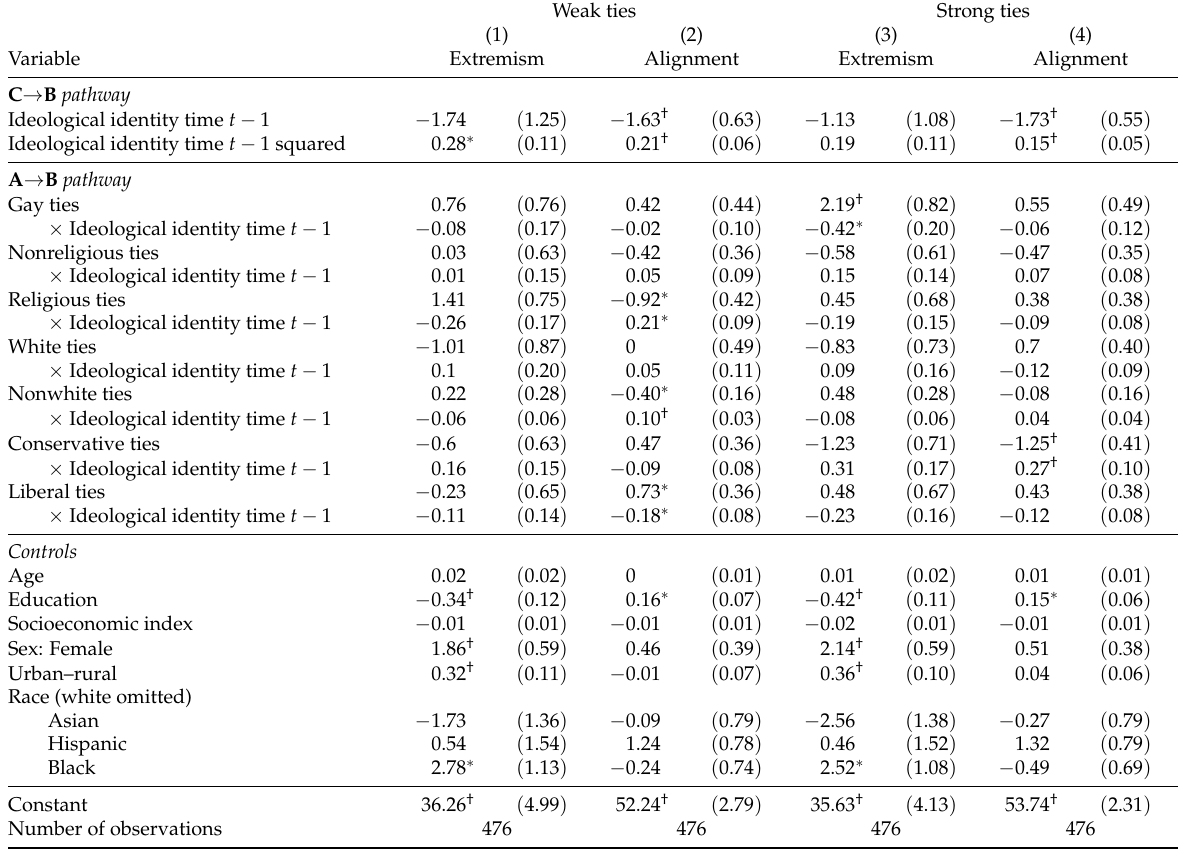
Table 2: HLMs predicting subsequent ideological organization of